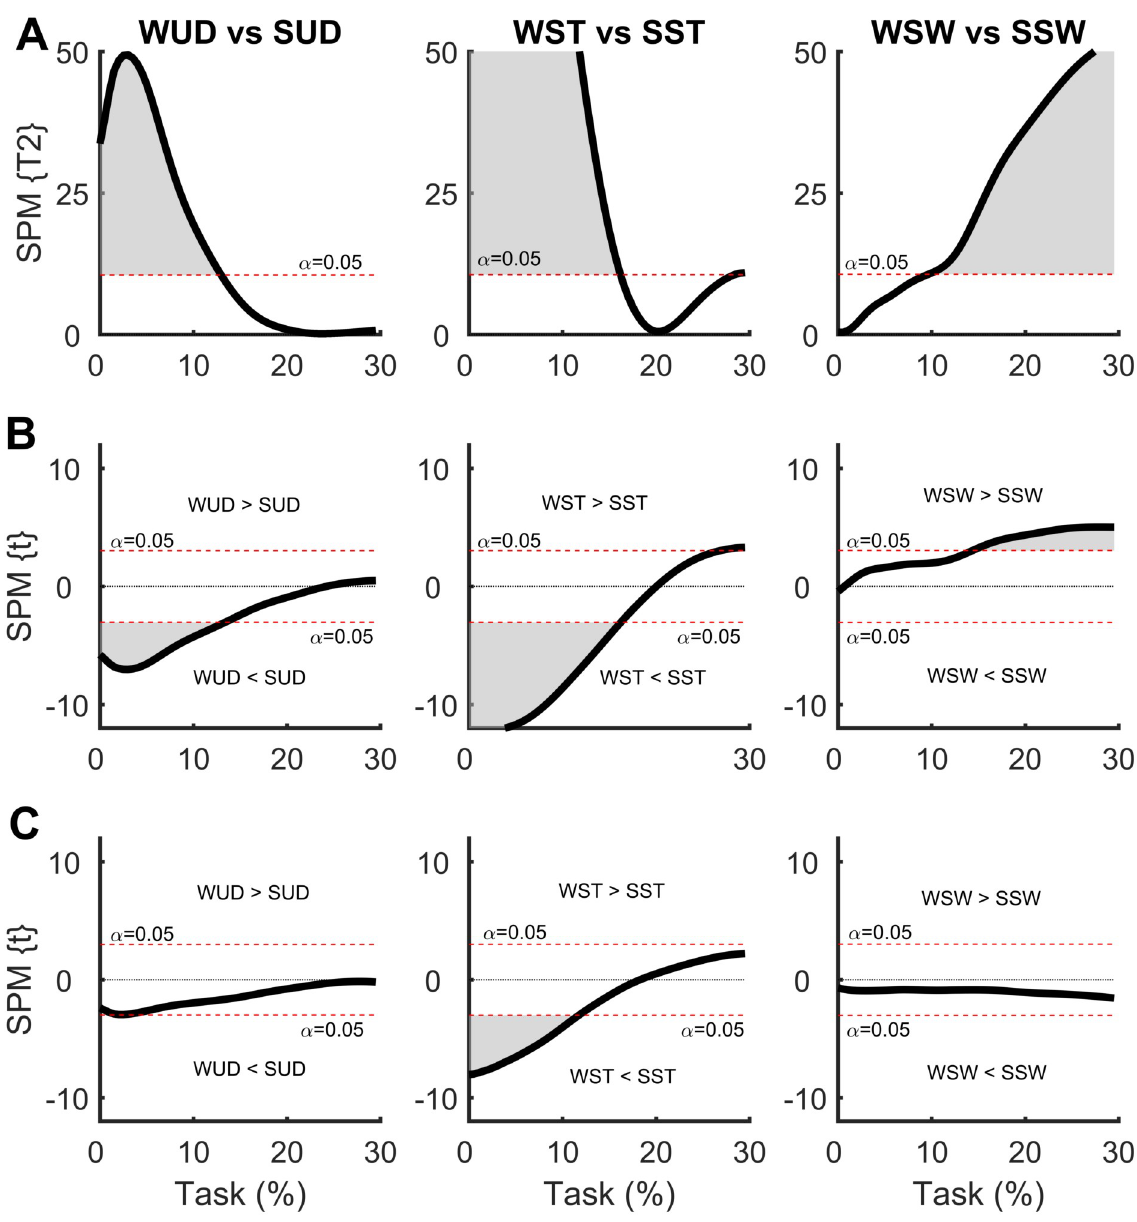
Fig 8. (A) Hotelling’s paired T-square test on the center of pressure (COP) displacement vector comparing the weight positioned at the waist with the weight positioned at the shoulder. Post hoc scalar t-tests on (B) medial-lateral (ML) COP and (C) anterior-posterior (AP) COP components. WUD and SUD: weight uniformly distributed at the waist and shoulder, respectively; WST and SST: weight positioned at the waist and shoulder, respectively, on the stance foot side; WSW and SSW: weight positioned at the waist and shoulder, respectively, on the swing foot